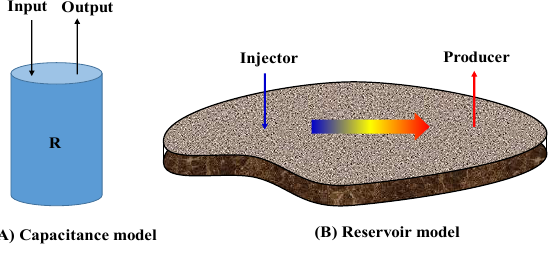
Figure 1. Schematic diagram of CRMs.